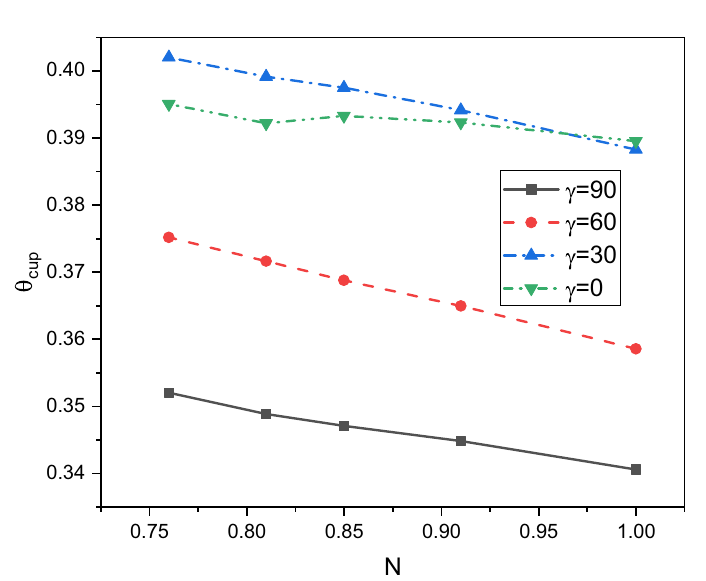
Figure 9. Impacts of the power-law index N and inclination angle γ on the cup-mixing temperature at Ra = 10 5 , Da = 10 − 3 , b = 0.6, d = 0.5, Ma = 1000, β = 0.95, τ = 1, φ = 2%, Rd = 1, � = 10 − 4